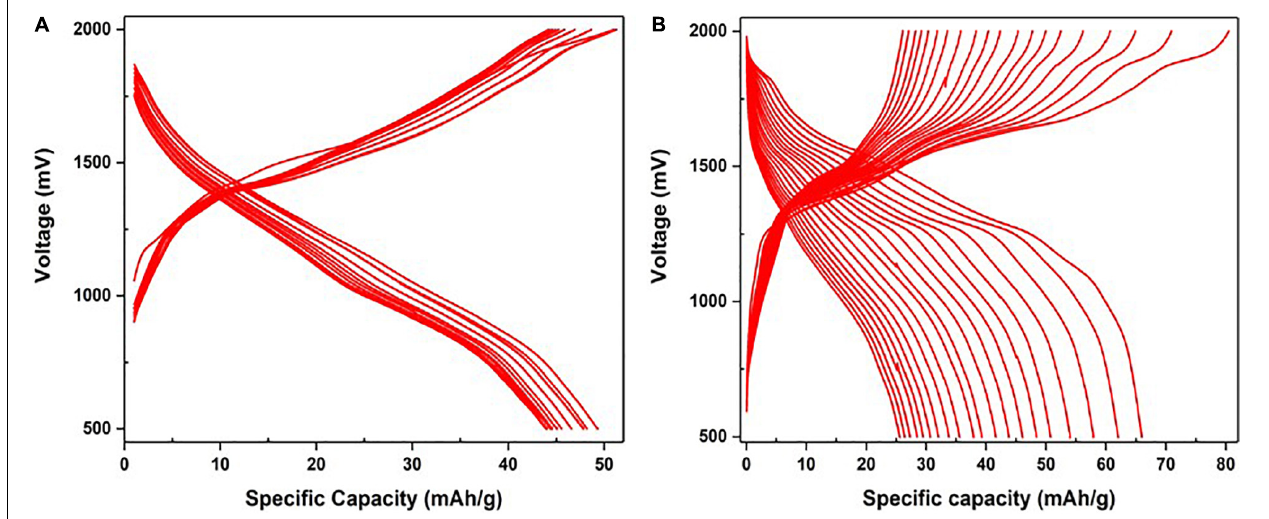
FIGURE 10 | Galvanostatic charge-discharge curves at 160 mA/g of (A) VOP1 and (B) VOP2 in half-cells using Zn as reference and counter electrodes and 3 M ZnSO 4 .7H 2 0 as